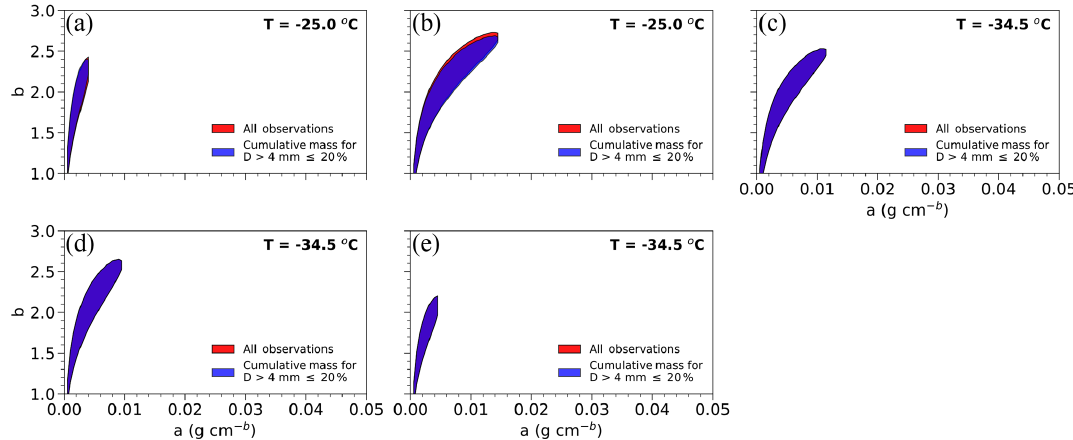
Figure 7. Surfaces of equally plausible a and b values from the m = aD b relation from each near-constant-temperature leg on 23 May 2011 for all coincident observations (red) and only those where cumulative mass for D > 4mm is ≤ 20% (blue). Flight legs of the same tempera- ture are shown in chronological